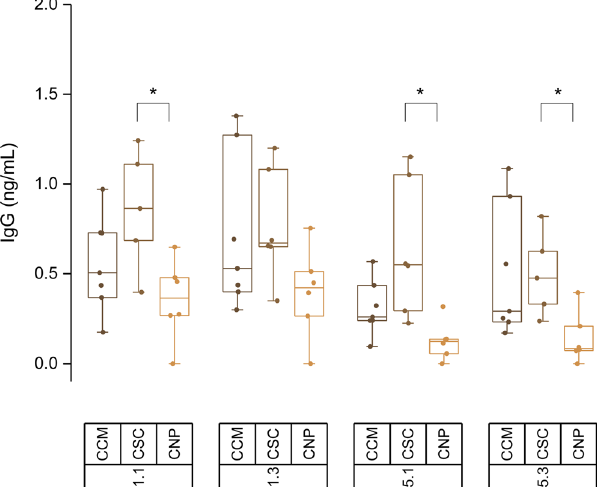
Figure 4. IgG reactivity of children serum samples from the endemic malaria region with four selected 20-mer epitopes. Data shows specific IgG concentration present in sera against 20-mer peptides sequences of START (1.1, 1.3) and PDI8 (5.1, 5.3). Three different sera groups were used: clinical malaria samples (CCM, parasitemia > 0.1%); asymptomatic subclinical (CSC), and undetected malaria parasite (CNP). Mean values are given by horizontal lines; boxes depict 25/75 percentiles and whiskers cover data excluding outliers at 1.5 coefficient. Mann-Whitney nonparametric tests were run: * P <